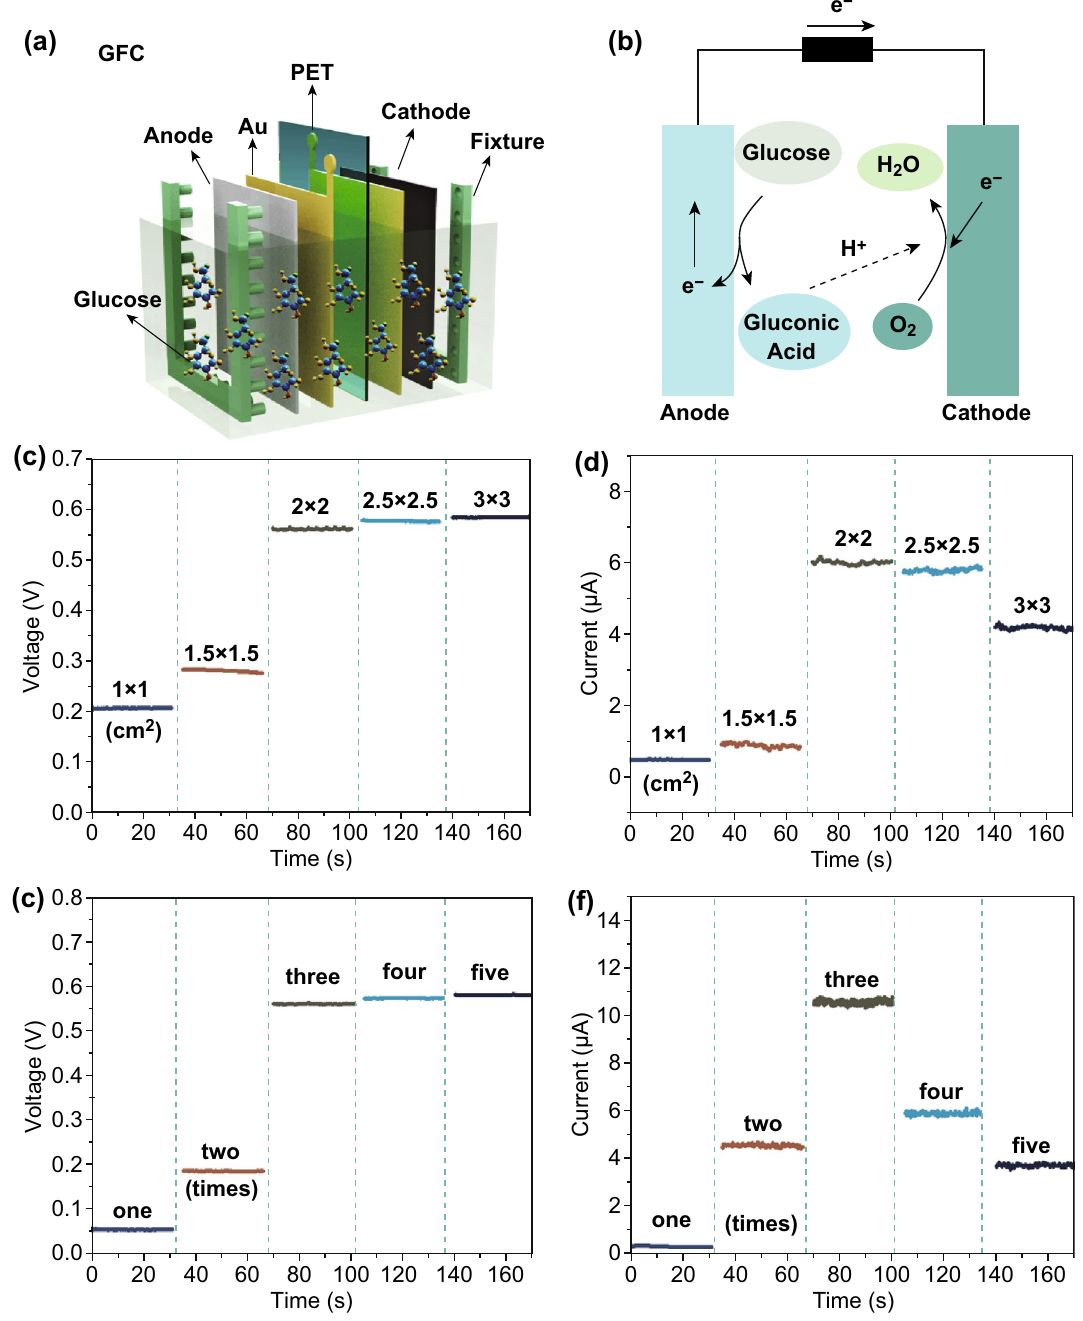
Fig. 4 a Structure diagram of GFC in glucose solution. b Redox reaction of glucose at anode and cathode. c, d Variation of output voltage and current with different sizes. e–f Variation of output voltage and current with different loading times of Pt–Pd